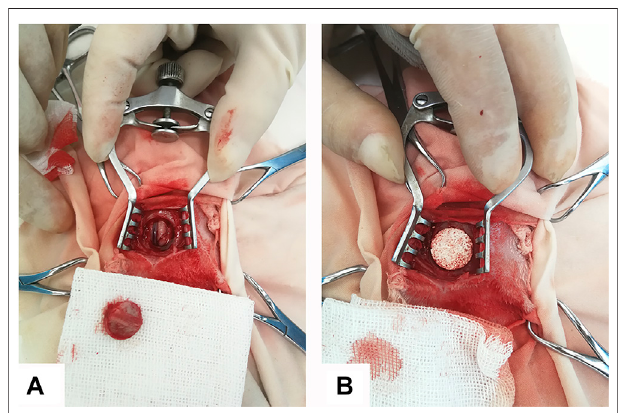
FIGURE 1 | Rabbit calvarial defect and implantation with porous scaffold. (A) 12.8 mm calvarial defect was created in rabbit calvarial midshaft. (B) CaP-based scaffold with size 12.8 mm was implanted into the defect region.